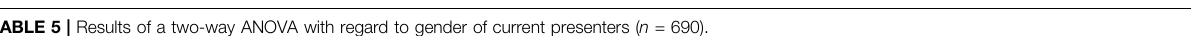
TABLE 5 | Results of a two-way ANOVA with regard to gender of current presenters ( n = 690). Scale Df Mean square F Sig. Effect size R